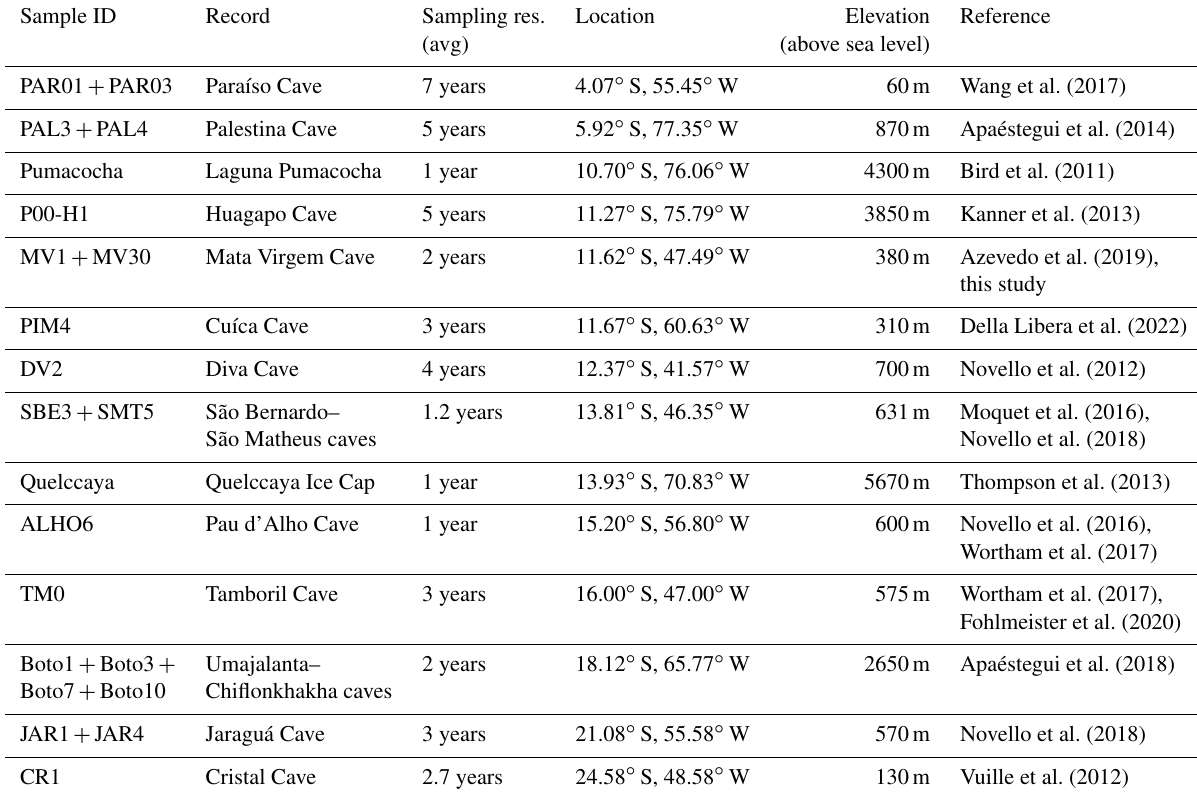
Table 1. Oxygen isotope proxy